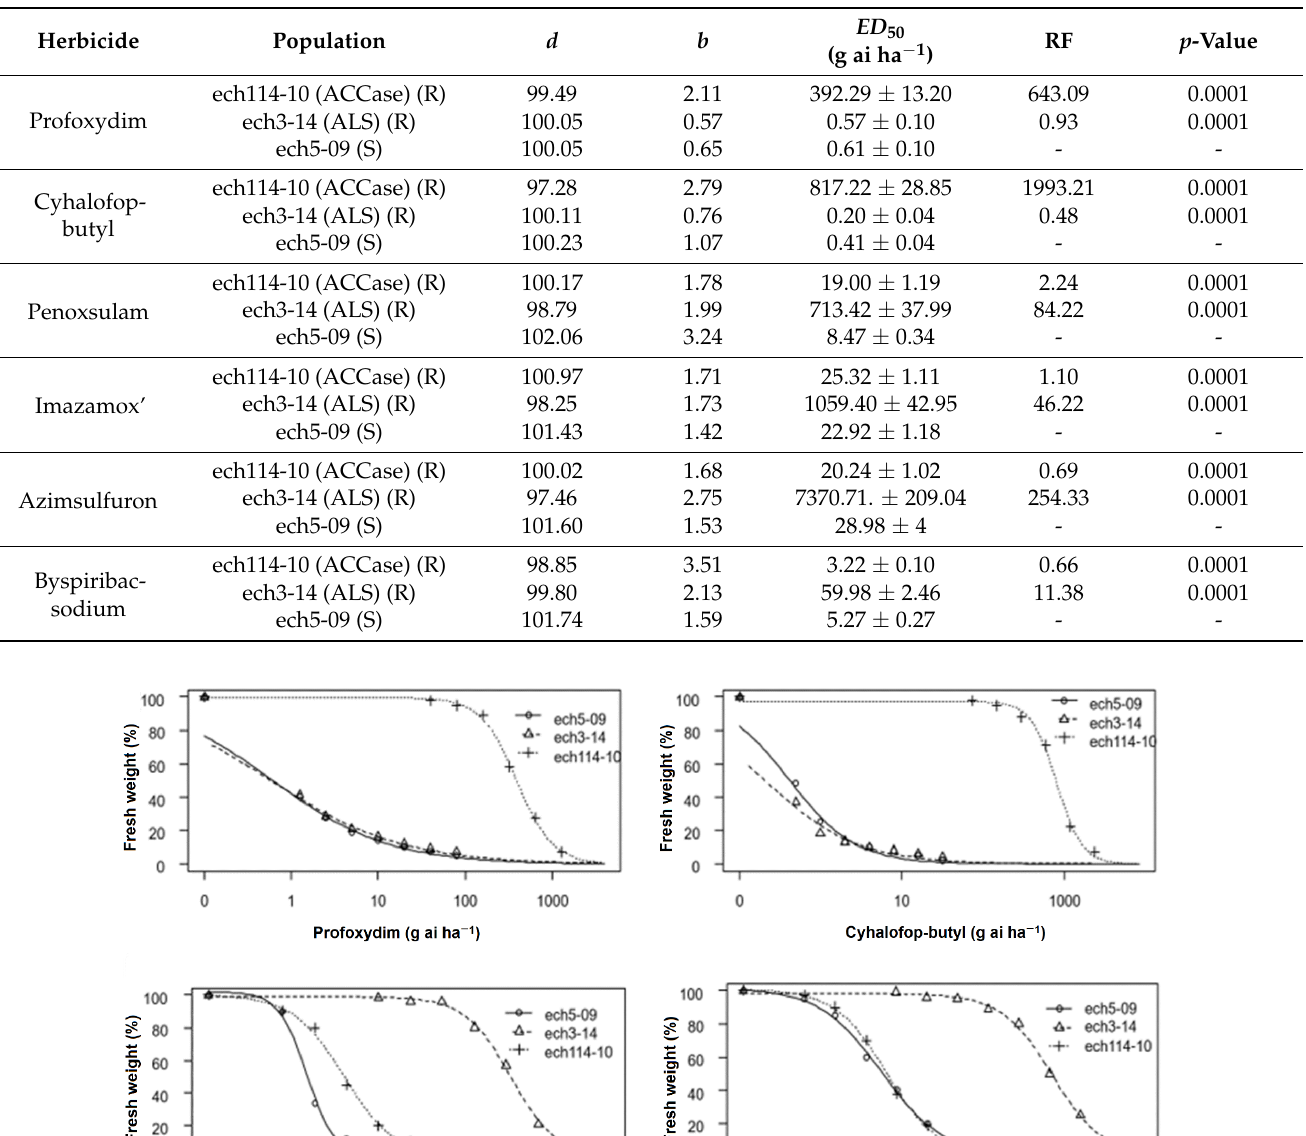
Table 6. Parameter estimates from the logistic analysis of growth reduction ( ED 50 ) of the selected resistant (R) (ALS and ACCase-inhibiting herbicides) and susceptible (S) biotypes under increasing ALS and ACCase-inhibiting herbicide rates.